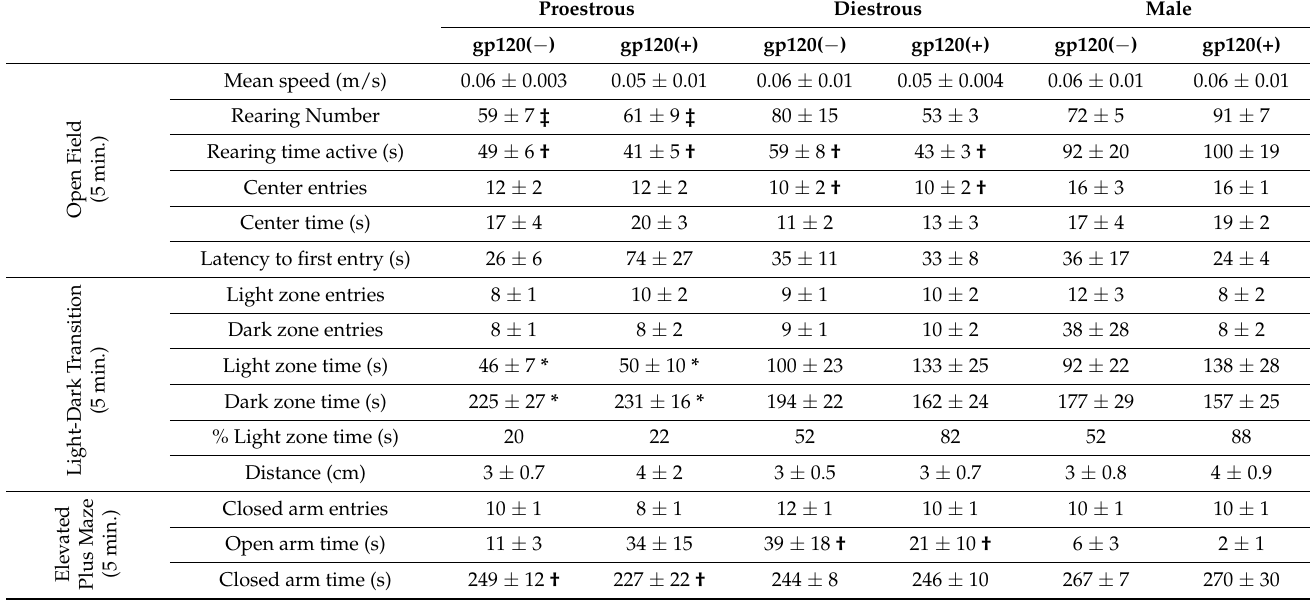
Table 1. Anxiety-like behavior of female and male mice that expressed gp120 [gp120(+)] or did not [gp120( − )] (n = 8–9/group). Females were tested in either the proestrous or diestrous phase of their estrous cycle. * main effect of condition wherein proestrous females significantly differ from all other groups; † main effect of sex wherein the indicated group significantly differs from males; ‡ sex × genotype interaction wherein proestrous females significantly differ from males, p ≤ 0.05. Proestrous